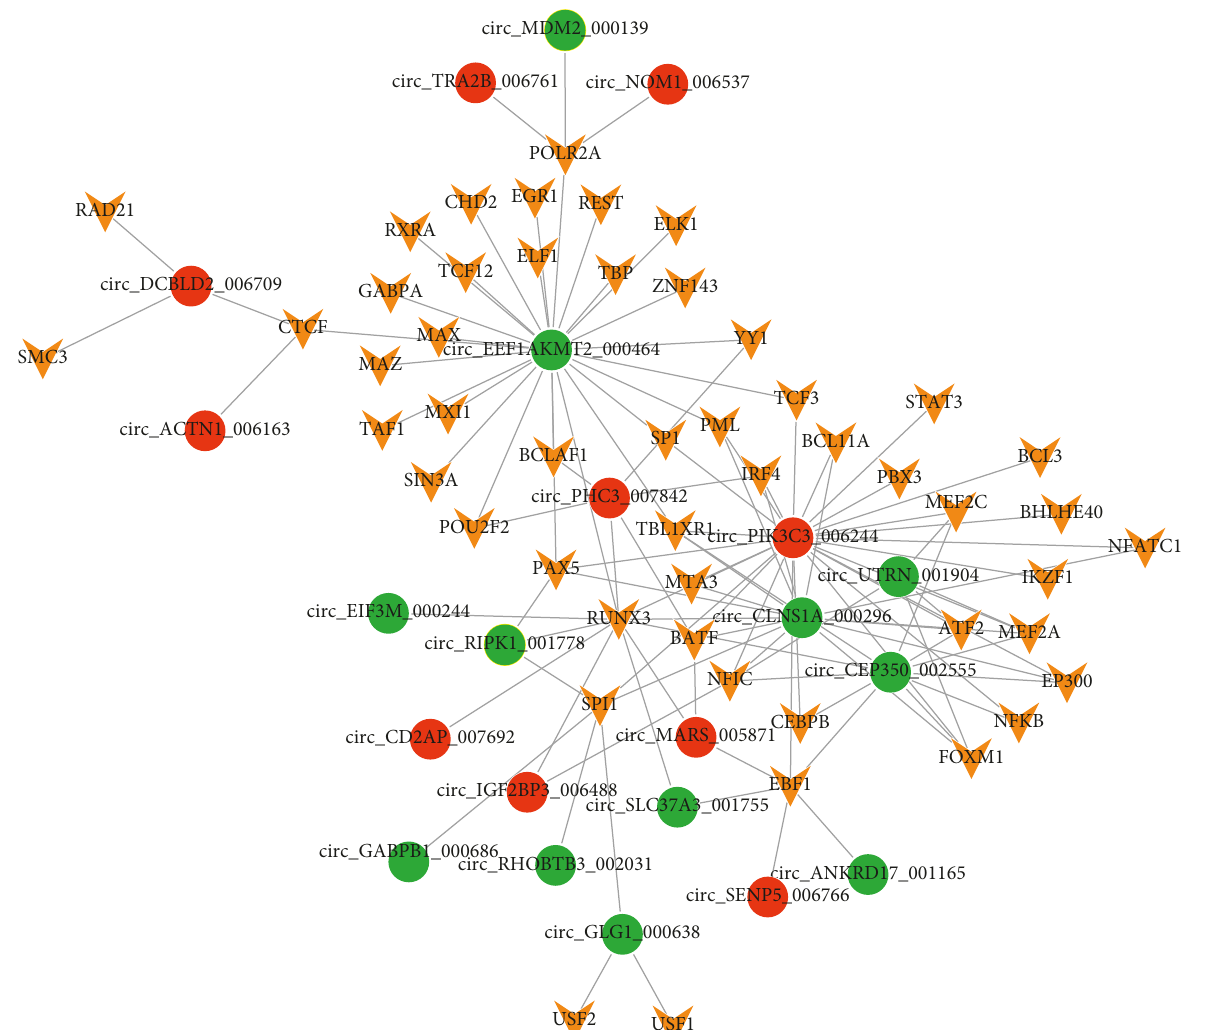
Figure 5: The transcription factor (TF)-circRNA regulatory network. Orange inverted triangles represent TFs. Red circles and green circles represent upregulated circRNAs and downregulated circRNAs, respectively. The circles with yellow ring represent the disease-associated